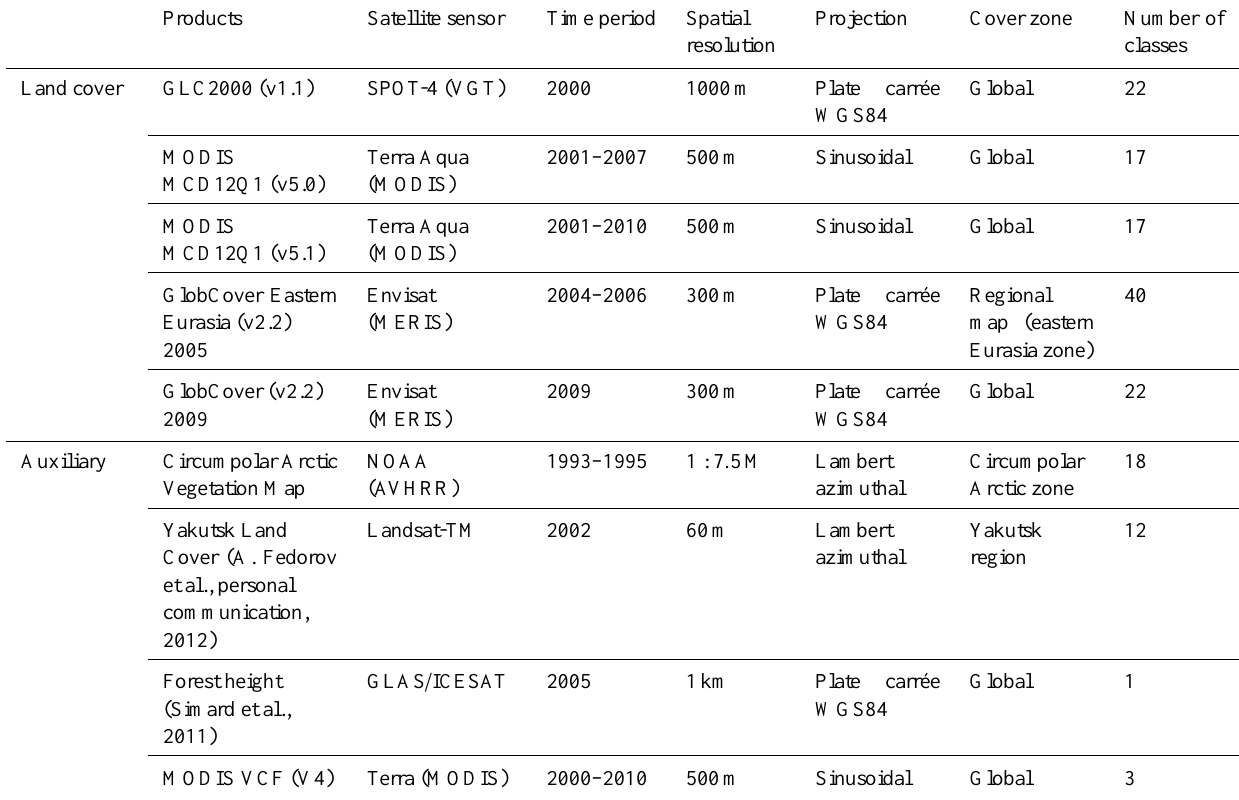
Table 1. List of the land cover products used and their characteristics. Products Satellite sensor Time period Spatial Land cover GLC2000 (v1.1) SPOT-4 (VGT) 2000 1000m Plate carrée